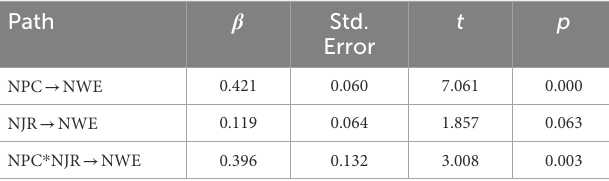
TABLE 7 The moderating effect test result.